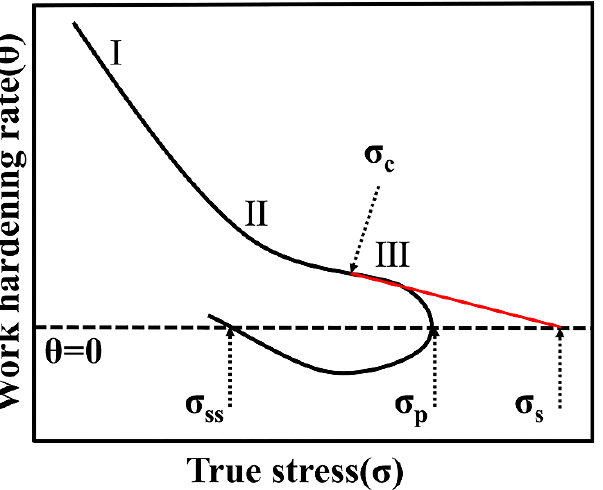
Figure 8. Schematic diagram of the relationship between work- hardening rate (θ) and fl ow stress